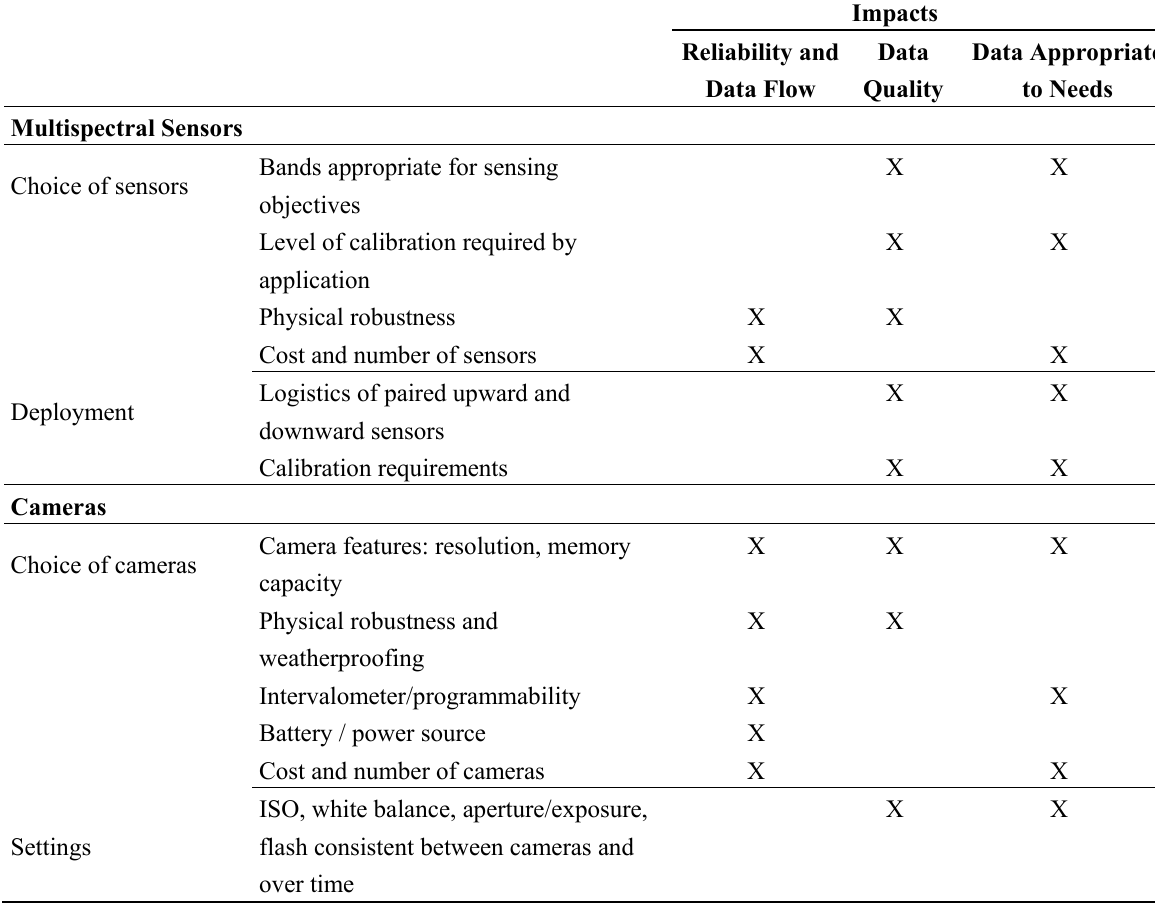
Table 1. Summary of the key issues in designing, operating proximal sensors within a WSN for vegetation monitoring and their potential impacts on the success of a WSN